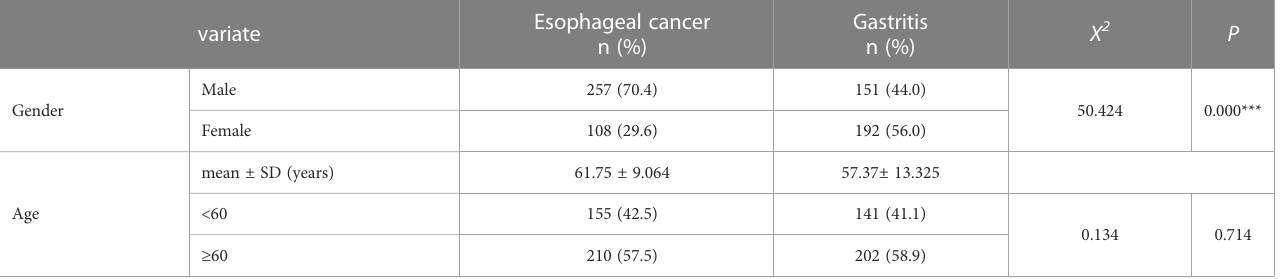
TABLE 1 Univariate analysis of esophageal cancer-related risk factors (demographic factors).